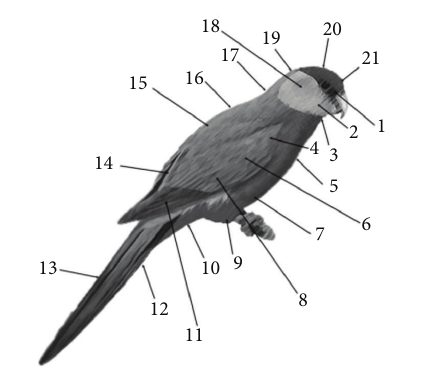
Figure 2: Parrot feature regions. 1: lores, 2: cheek, 3: throat,